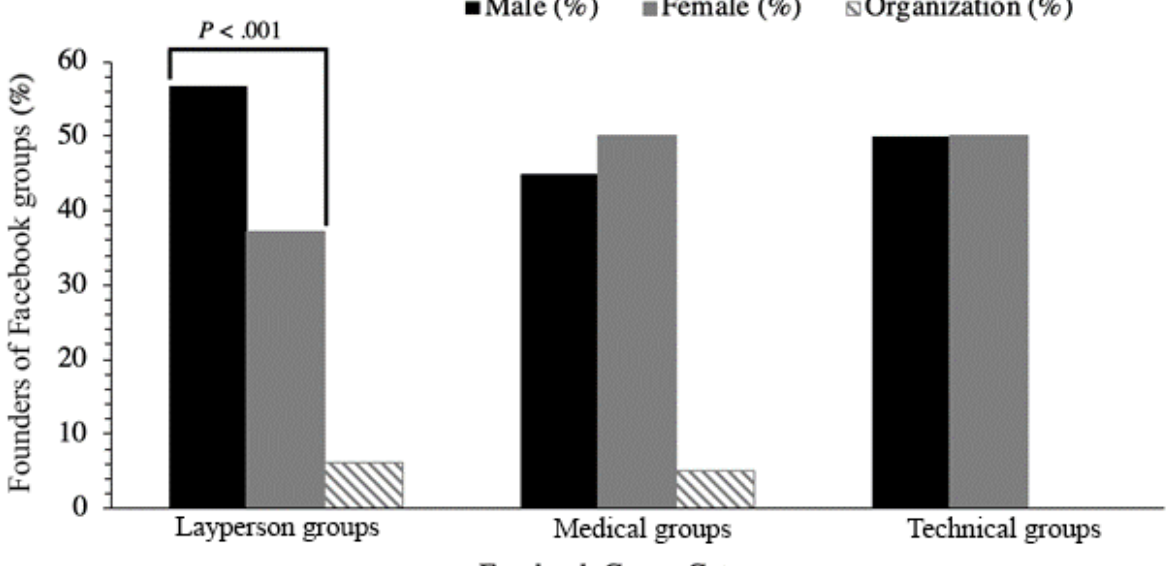
Figure 2. Gender of the creator of COVID-19–related Facebook groups by group